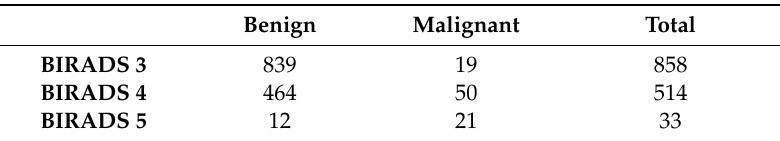
Table 4. Conventional breast ultrasound Breast Imaging Reporting and Data System (BIRADS) scores and malignancies (1405 nodules).